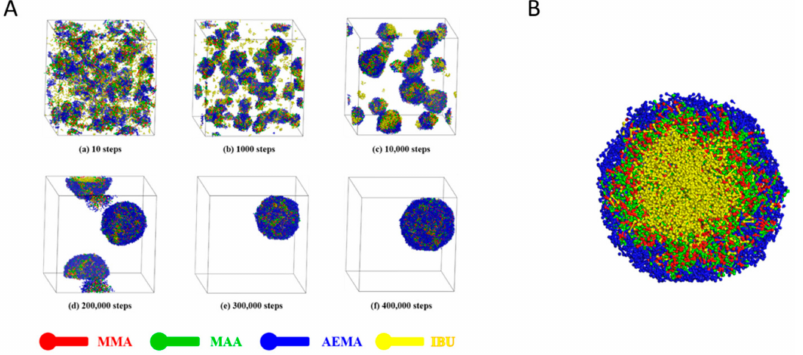
Figure 5. ( A ) Self-assembly process of IBU-loaded poly(MMA 30 - co -MAA 33 )- b -PAEMA 38 PMs with 6% IBU in aqueous solution. ( B ) Cross-section view of IBU-loaded poly(MMA 30 - co -MAA 33 )- b -PAEMA 38 PMs with 6% IBU at 400,000 steps during DPD